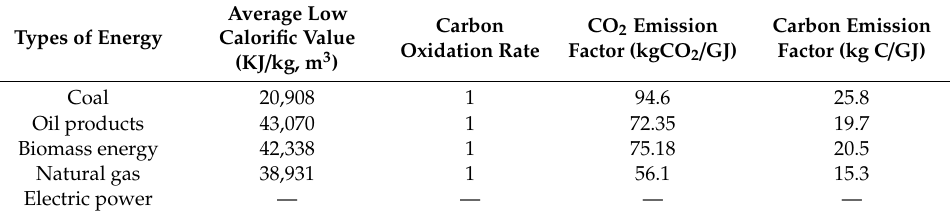
Table 2. Carbon emission coe ffi cient of transportation and energy.